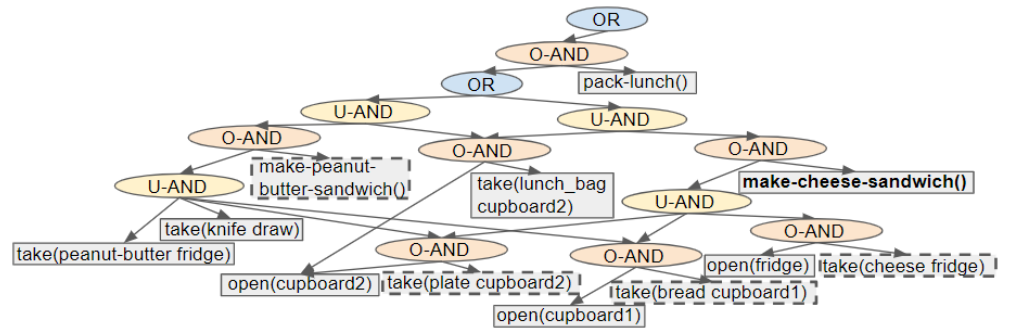
Figure 6. Example of the steps taken to create an Action Graph, when the first goal is (lunch_packed) , which can be achieved by retrieving a lunch bag, and making either a cheese or peanut butter sandwich. Actions with a dashed border are currently in the BFS queue and the bold actions indicate the action which has just been popped from the queue. The algorithm continues until the queue is empty; only the first steps are provided to prevent the graph becoming